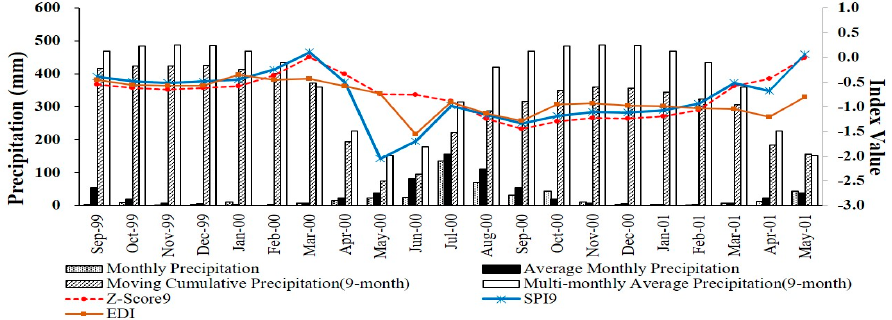
Figure 5. Changes of precipitation and drought indices for the nine-month timestep in Keshan station from September 1999 to May 2001.